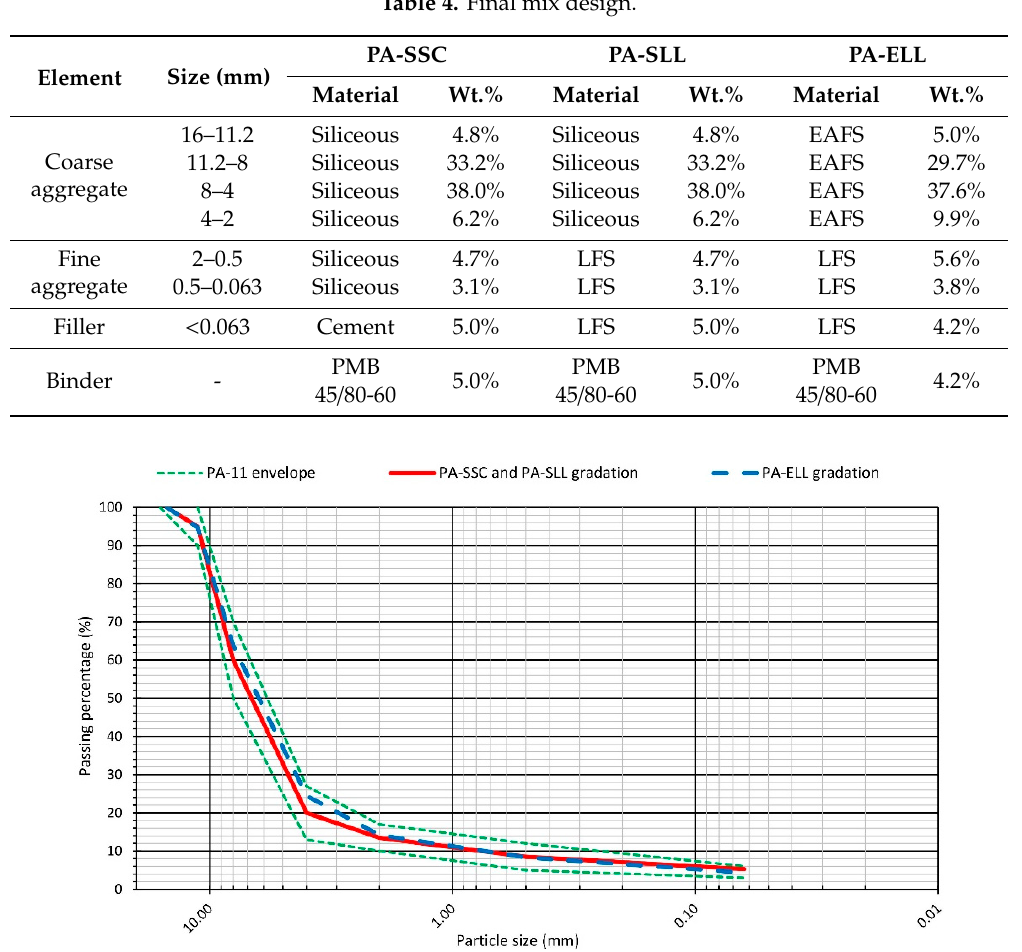
Figure 4. Particle size gradation of the mixtures.